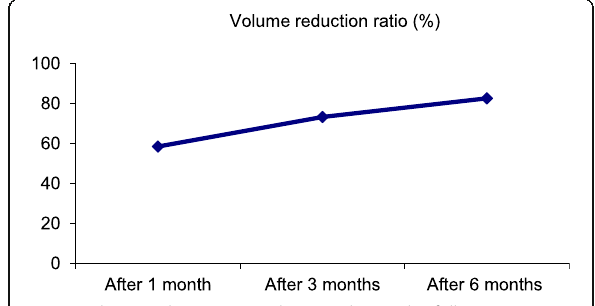
Fig. 4 Volume reduction ratio changes during the